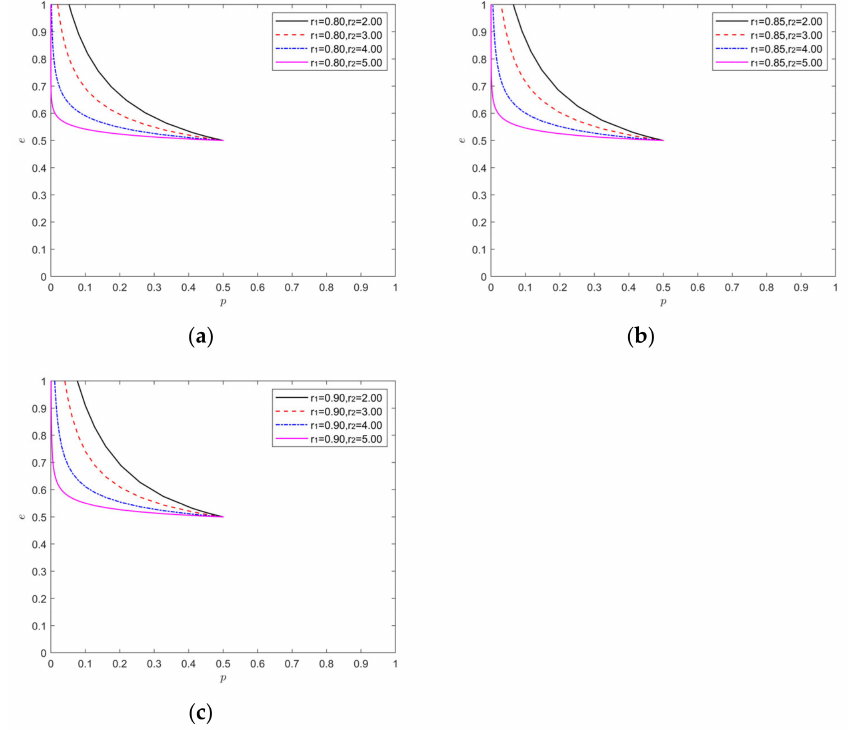
Figure 4. The development of the game’s strategy in a (optimistic, pessimistic) condition. ( a – c ) represent the results of different parameter values.